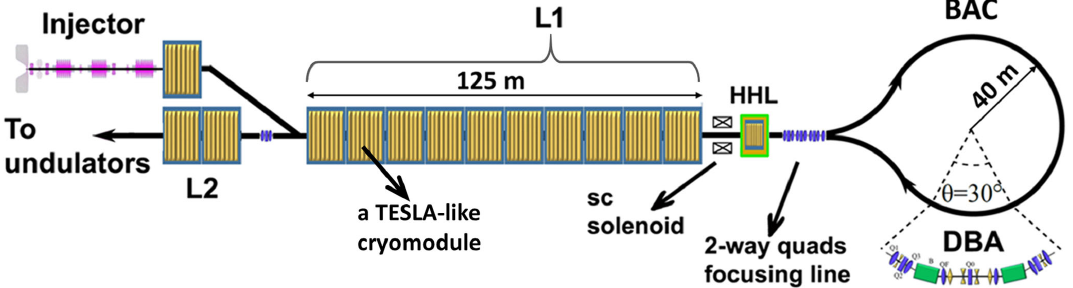
FIG. 1. MariX facility layout, not to scale. The injector delivers the beam to the main booster linac (L1) through a dogleg. The L1 region (or two-way region) ends with a quadrupole matching and focusing line at the end of which the beam enters the bubble arc compressor (BAC) used to compress and for the beam u-turn. The beam is accelerated again in L1 and is finally energy-tuned in the linac